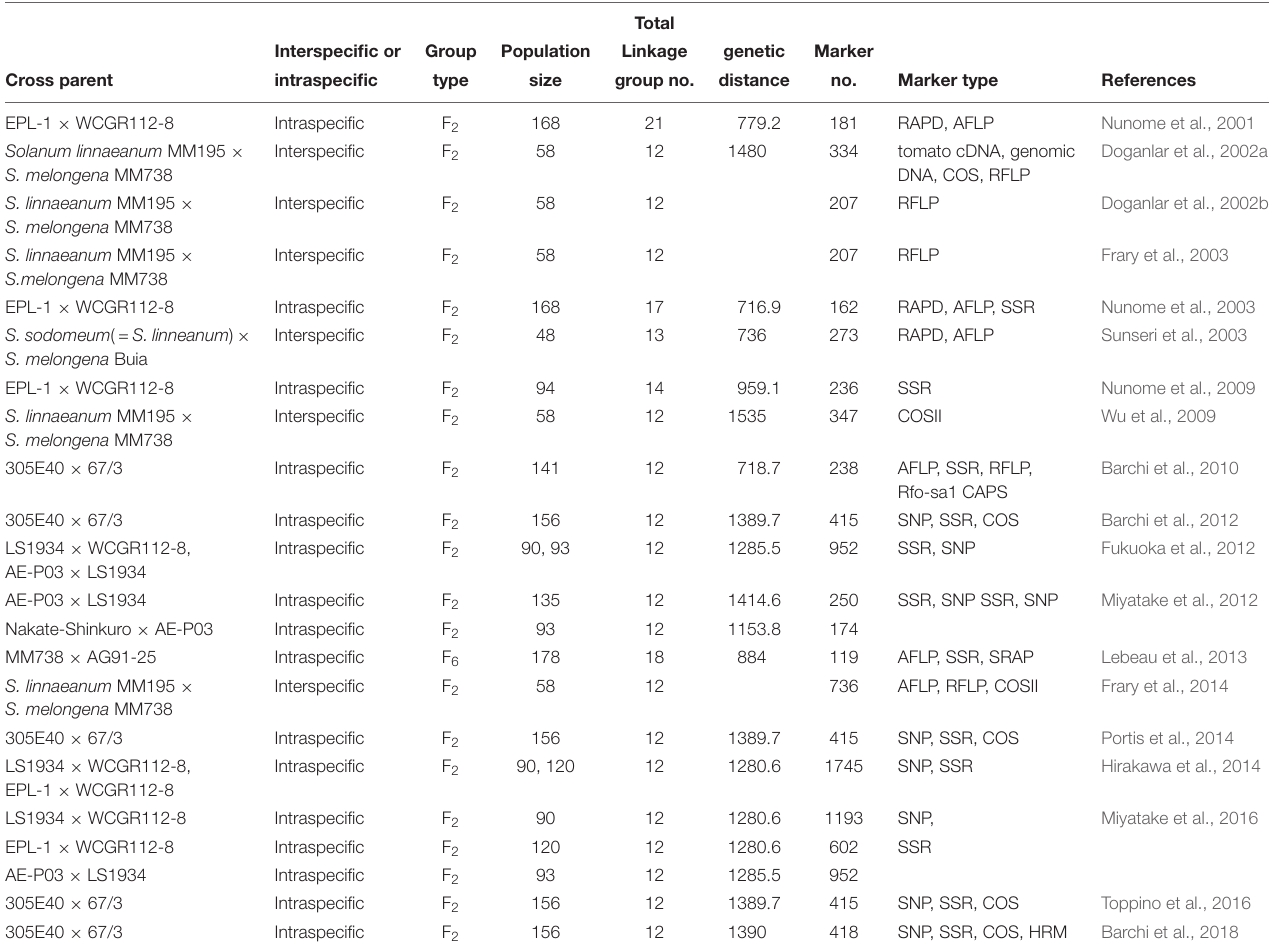
TABLE 4 | Summery of previously reported genetic maps in